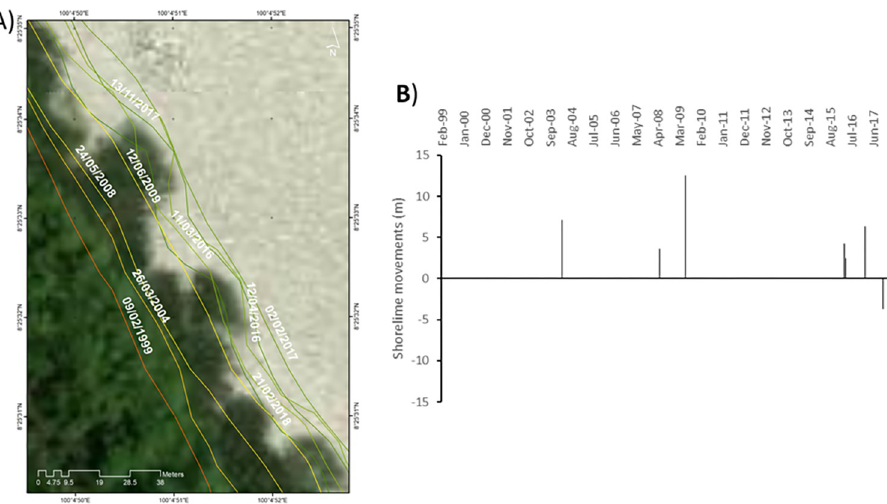
Fig 7. Representations of shoreline movements observed during the survey period in site 2. A) Visualisation of the shoreline positions for the highest water level marks digitised with CoastSat. B) Shoreline movements measured using DSAS between two consecutives chronologically ordered digitised shorelines; negative values correspond to erosion and positive values to accretion. Basemap satellite images accessed from World Imagery ESRI Tile Layer. Credits: Esri, Maxar, GeoEye, Earthstar Geographics, CNES/Airbus DS, USDA, USGS, AeroGRID, IGN, and the GIS User